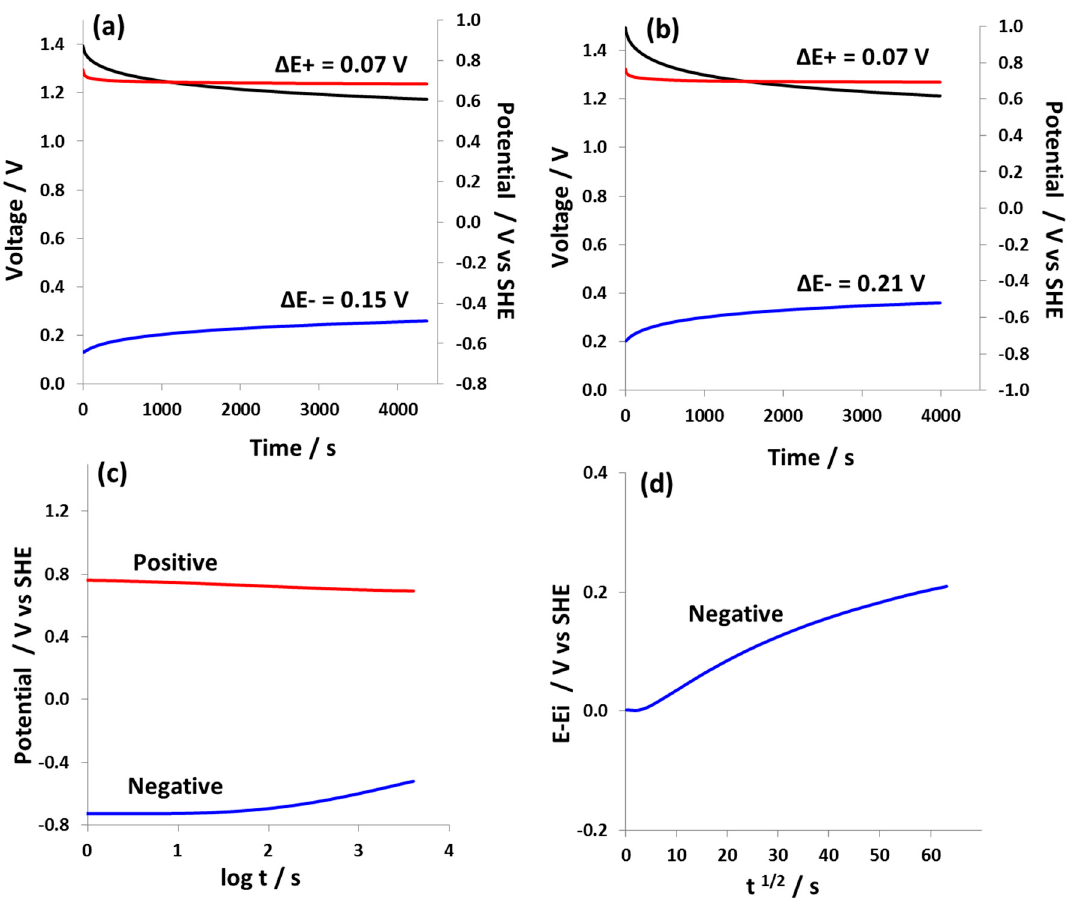
Figure 8. Self-discharge of hybrid cell 2 equipped with a reference electrode at cell voltage of ( a ) 1.4 V and ( b ) 1.5 V; ( c ) potential profiles of positive and negative electrodes versus log t and ( d ) and E-Ei versus t 1/2 for the negative EDL electrode.